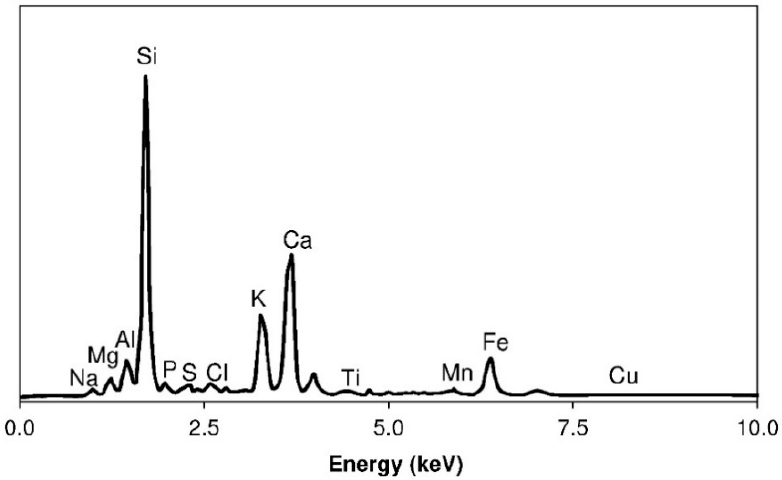
Figure 1. EDXA characterization of WCSA.